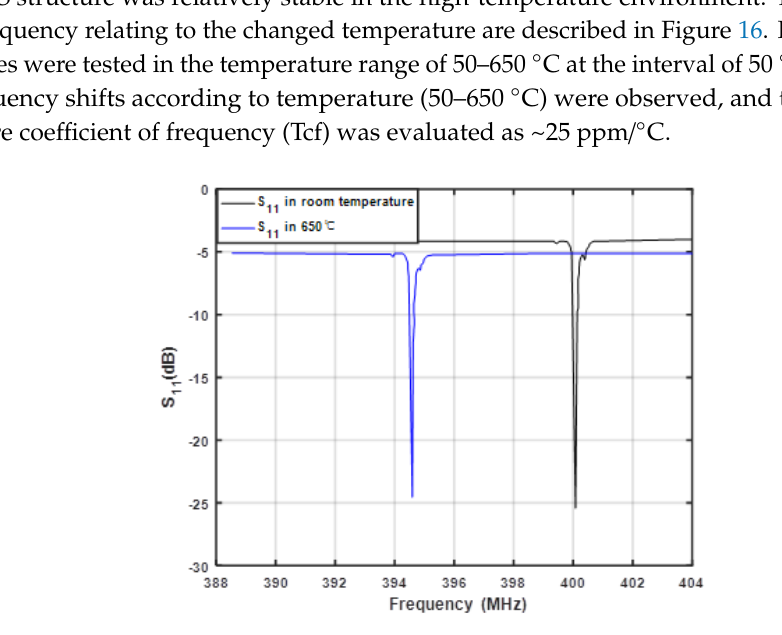
Figure 15. The measured S 11 of the prepared SAW sensing devices at various temperatures.